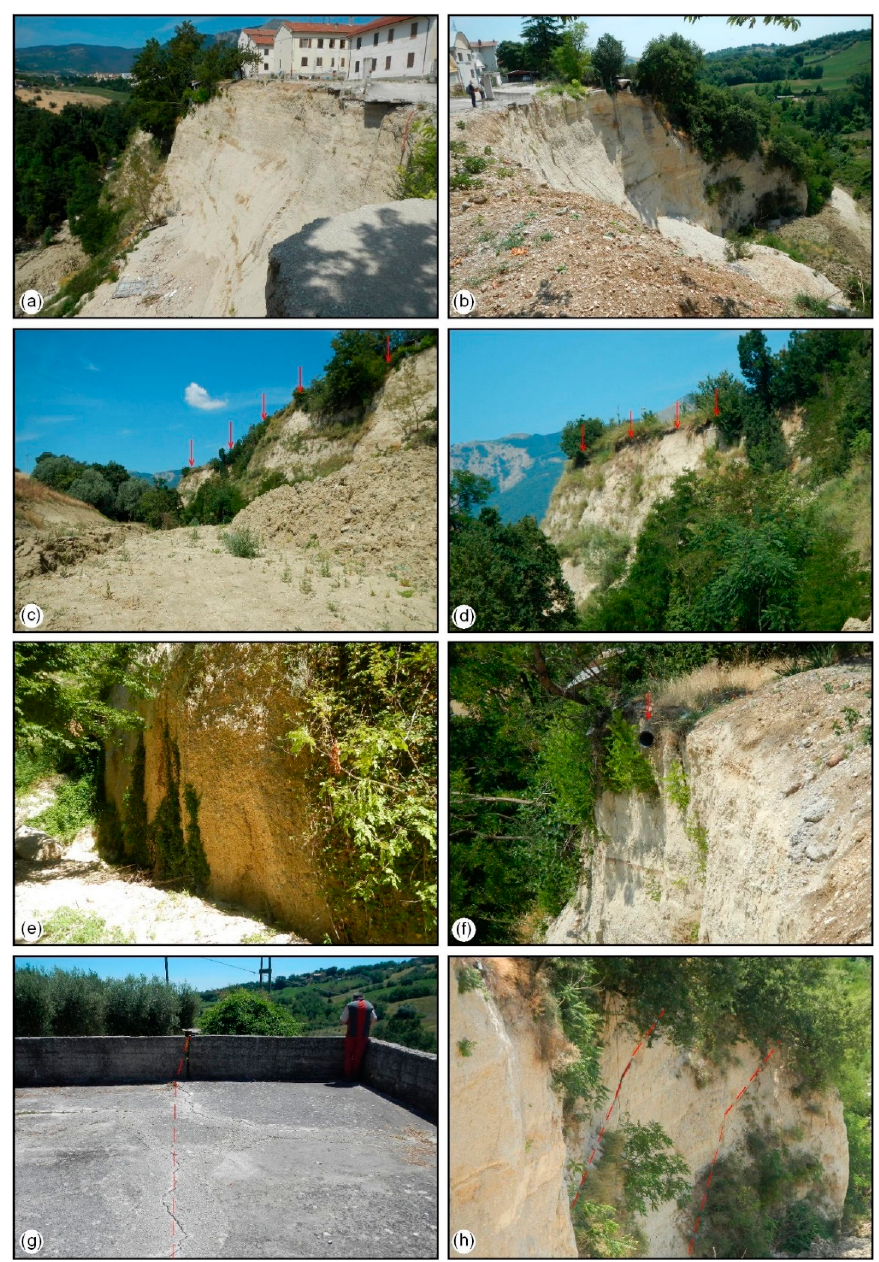
Figure 15. Geomorphological features of the Castelnuovo landslide: ( a ) main landslide scarp (western part); ( b ) main landslide scarp (eastern part); ( c ) polygenetic scarps (red arrows) of the Castelnuovo mesa relief (in the foreground the landslide body); ( d ) structural surface (red arrows) on top of the main scarp; ( e ) fluvial erosion scarp at the base of the main scarp; ( f ) damaged water pipe along the landslide scarp; ( g ) tension crack along a joint affecting the slope; ( h ) main joints affecting the slope in the landslide area.